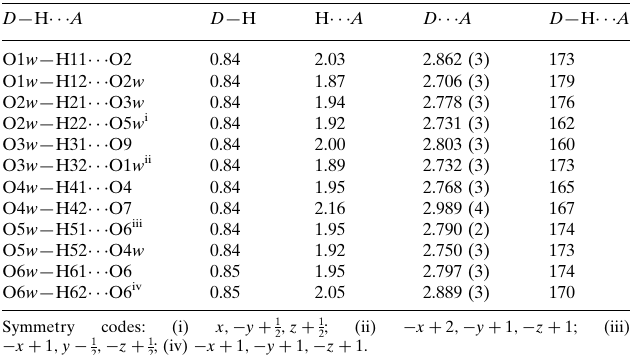
Hydrogen-bond geometry (A˚ , (cid:2)